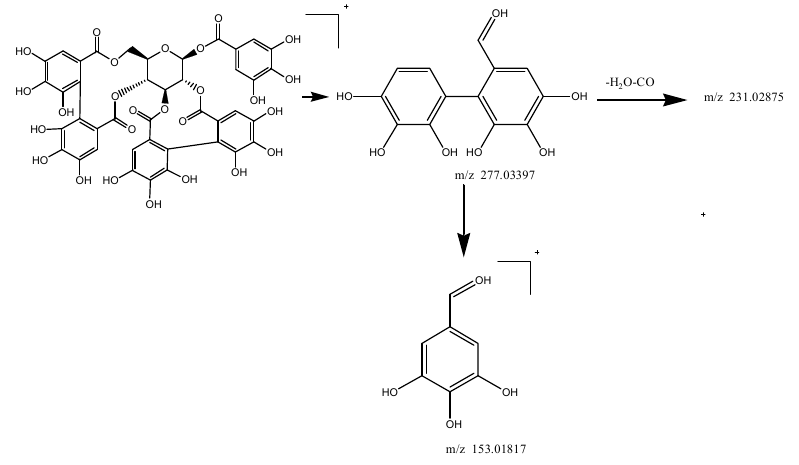
Figure 7. Fragmentation pathway of compound 109 .